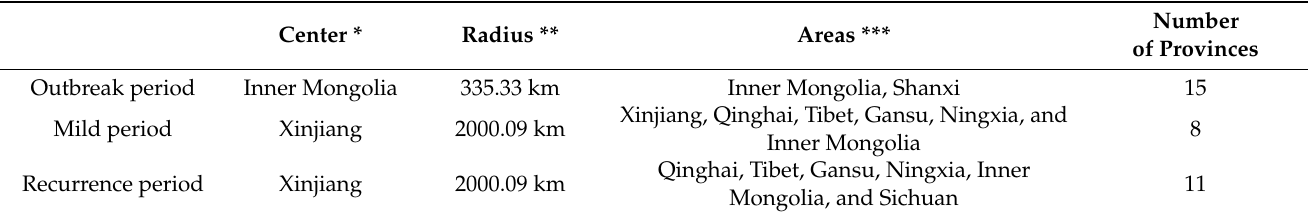
Table 3. Characteristics of statistically significant spatiotemporal clusters of Brucellosis.